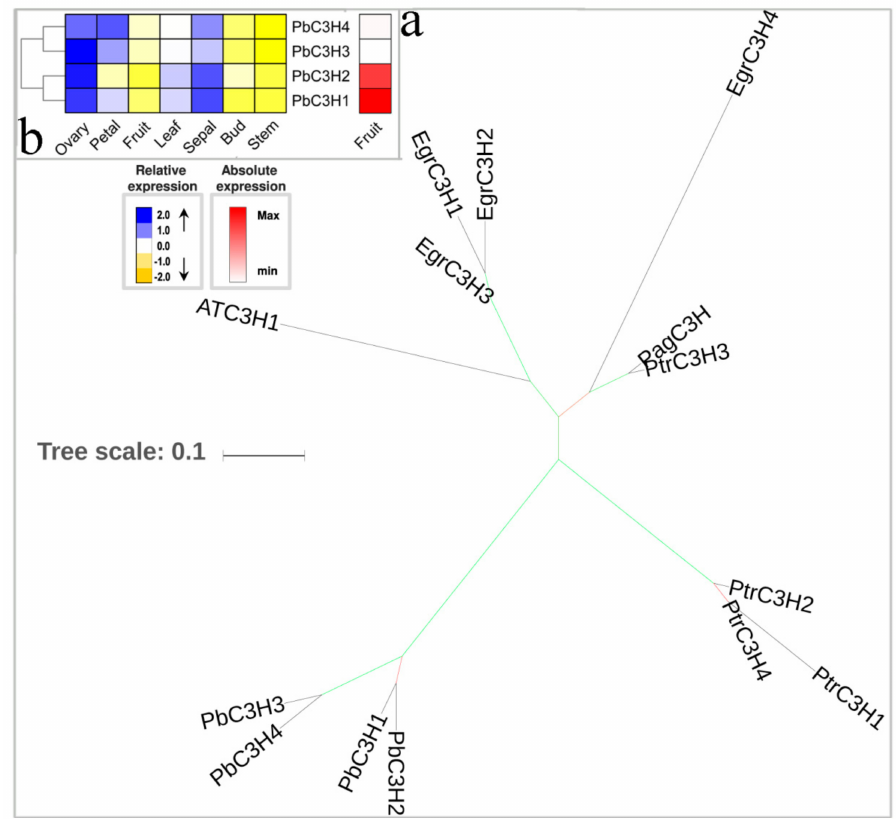
Figure 3. Phylogenetic tree and expression profiles of the C3H bona fide clade. ( a ) ML tree built with C3H bona fide enzymes from several species. ( b ) The expression profiles P. bretschneideri C3H bona fide genes. The green color of the tree branches suggests strong node support (bootstrap support ≥ Table S3. The gene accession number is indicated in Table S4. The tree scale is the number of amino acid substitution per